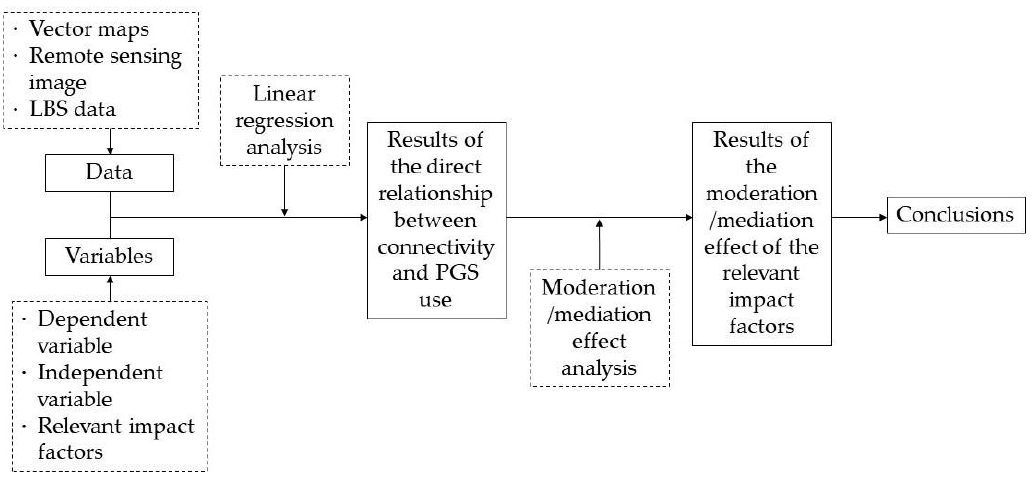
Figure 1. Research Figure 1. Research framework.